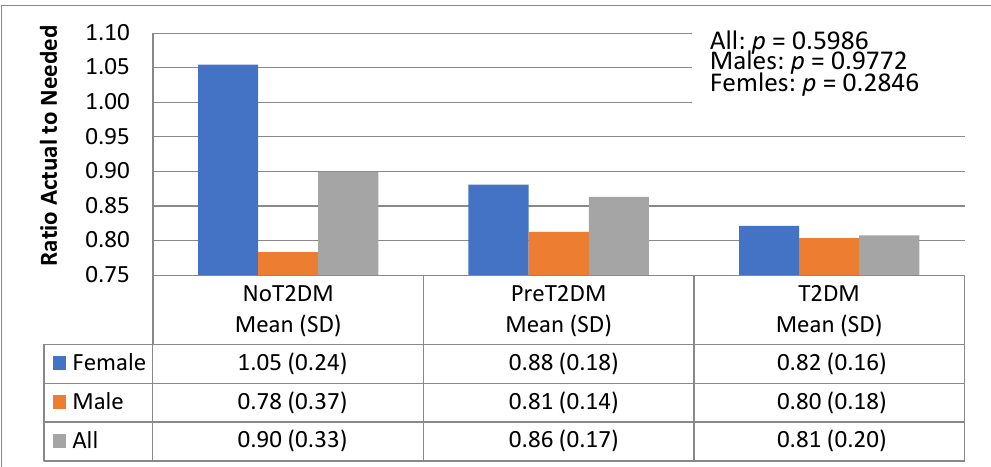
Figure 6. Actual to needed total kilocalories by diabetes status and gender.